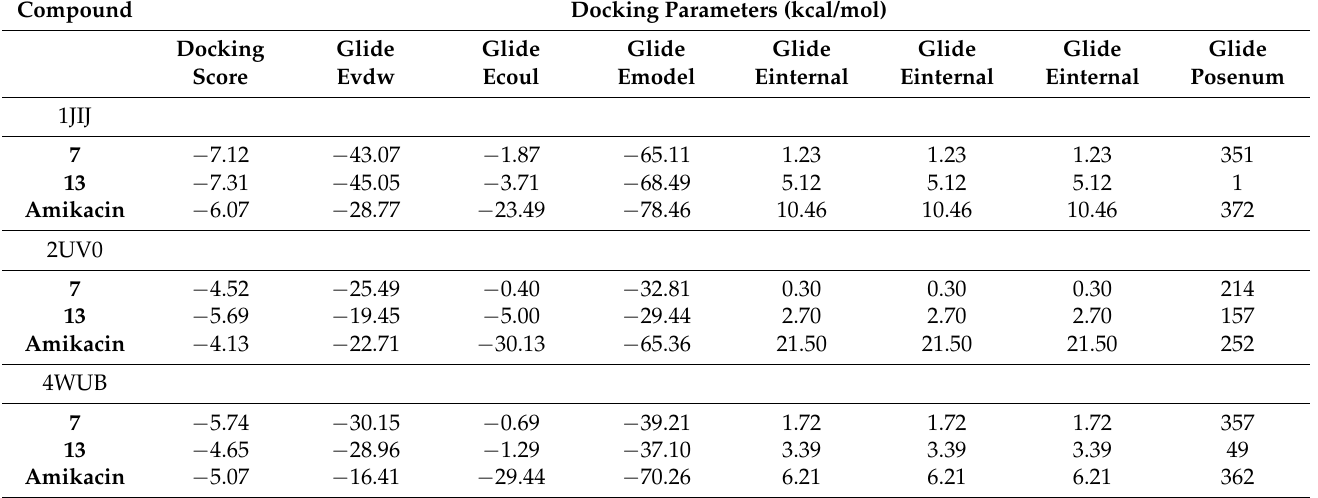
Docking results against S. aureus (PDB ID: 1JIJ) protein indicated a well-conserved binding region but with slightly different predicted best binding-energy values. The best free-binding energy was found for compound 13 ( − 7.31 kcal/mol), followed by compound ( − 7.12 kcal/mol), in comparison to the other investigated compounds; amikacin (reference molecule) displayed favorable binding energy value (Table 4). The observed trend in the binding free-energy was found to be consistent with the experimental activity trend for the title molecules. When the interactions between proteins and molecules are examined, in Figure 4a, it is seen that the carbonyl oxygen in the carboxylic acid group attached to the pyridazine ring forms hydrogen bonds with the LYS 84 and HIE 50 proteins. Figure 4a shows the 2D interaction diagram of the 2UV0- 13 docked structure. In comparison to the other compounds studied, compound 13 showed the best